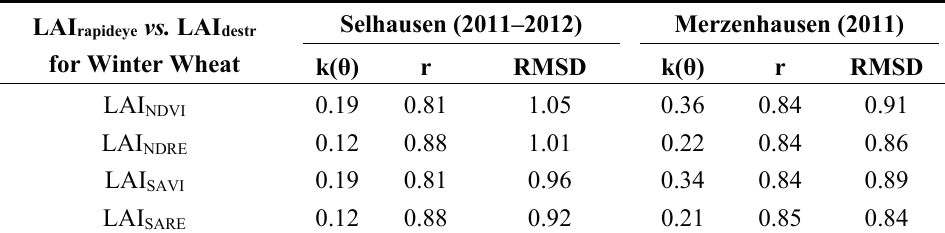
Table 4. Validation result through splitting the sample set into calibration and validation sets for LAI estimates from